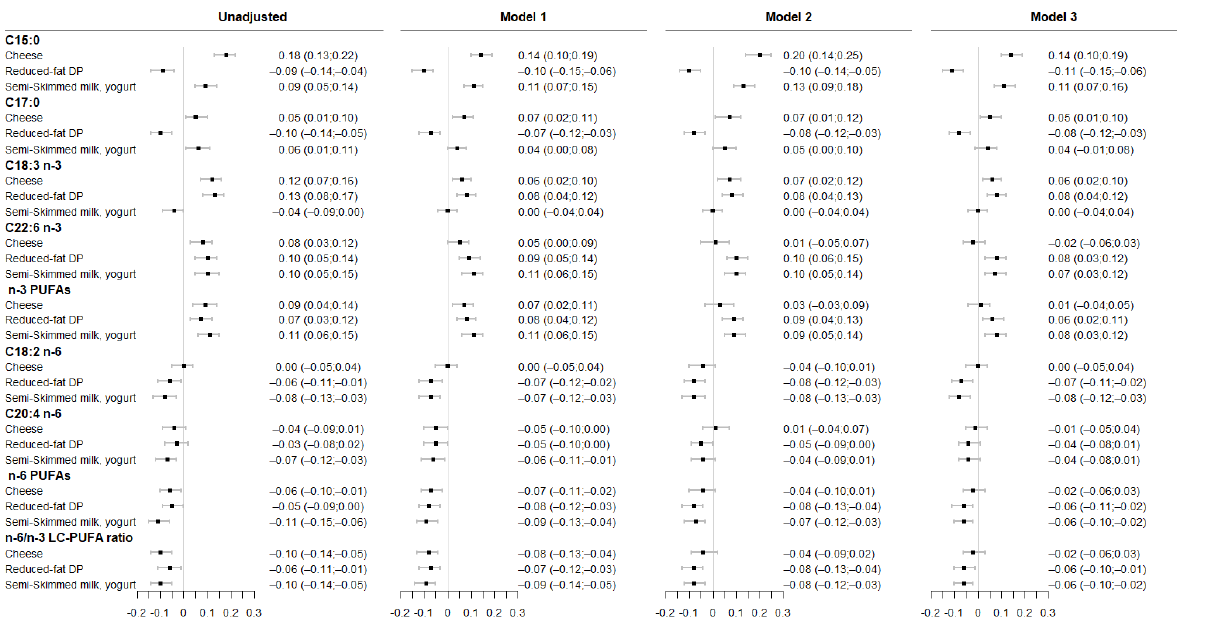
Associations between maternal DP patterns and fatty acids level in cord RBC mem-